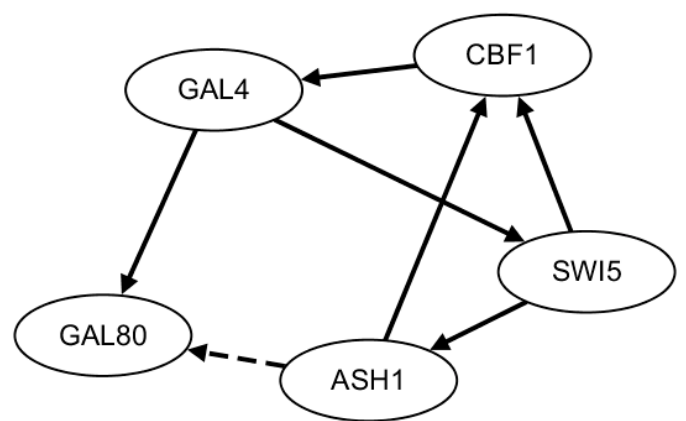
Figure 5. The inferred IRMA network with on dataset. The solid lines represent the true regulatory relationships and the dotted lines are the false positive regulations inferred.